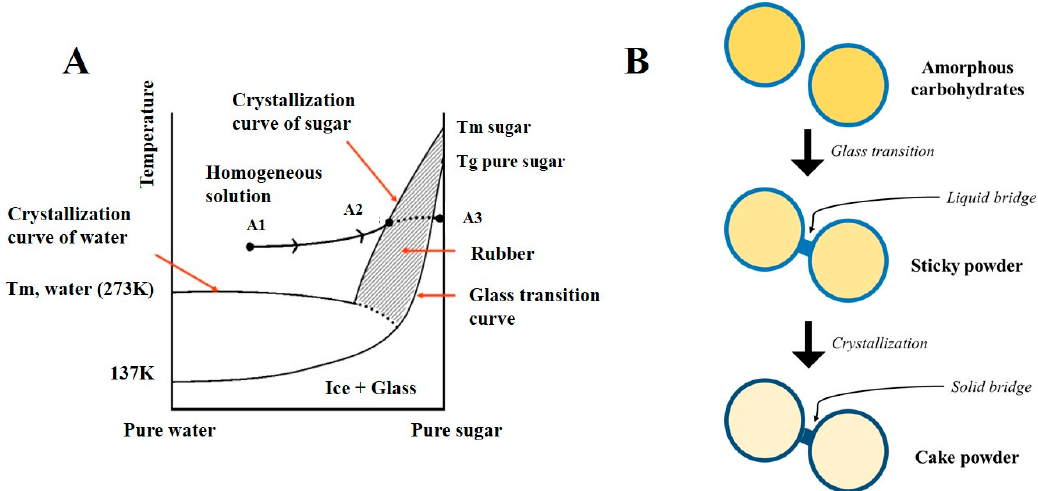
Figure 3. ( A ). Spray drying-state-diagram of a solution composed of sugar / water and a drug in a glassy matrix of sugar. (A1) Starting point composition. (A2) Point where the sugar solution (in the droplets) passes the crystallization curve of sugar. (A3) Spray-dried product in the amorphous glassy state. Reproduced from [39], which is an open access article distributed under the terms of the